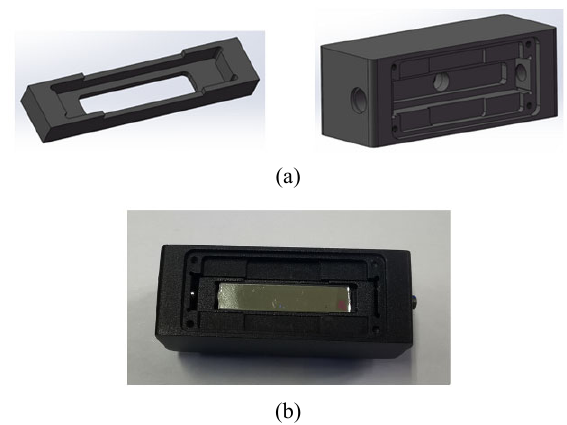
Fig. 6 Sectional view of the mechanical structure of the interferometer.